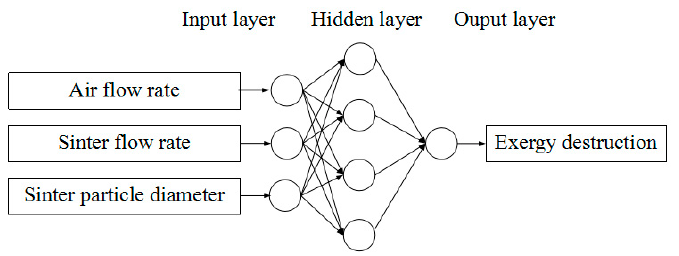
Figure 20. Structure of the back propagation (BP) neural network.